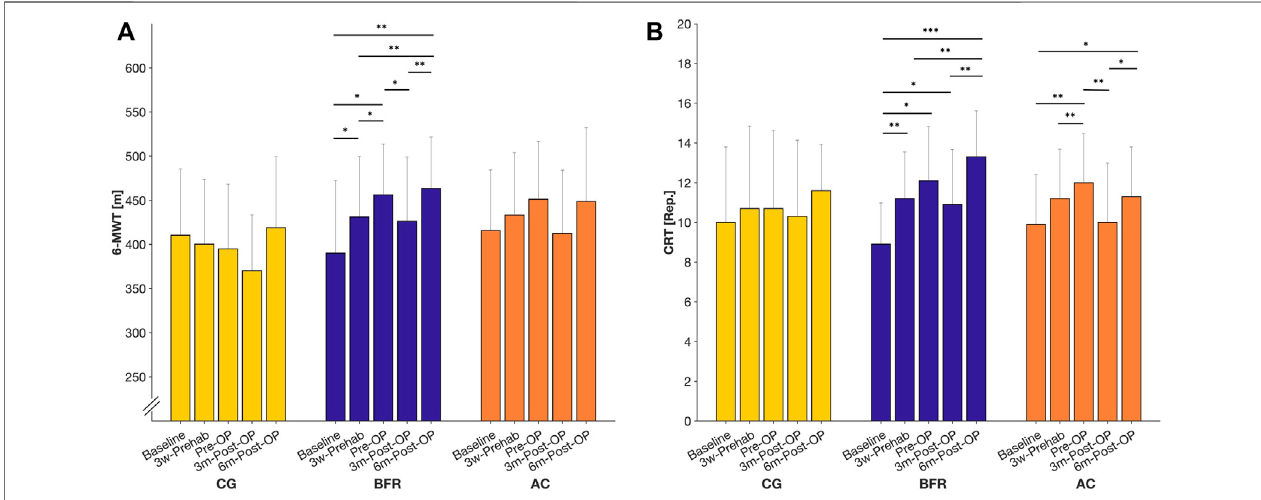
FIGURE 2 | Measures related to the 6-min walking test (6-MWT; (A) and chair-rising test (CRT; (B) during prehabilitation- and post-operative period. Data are provided as mean (standard deviation). CON = control group; BFR = BFR-training group; AC = active control group. *** p < 0.001, ** p < 0.01, * p < 0.05, signi fi cant difference within the respective